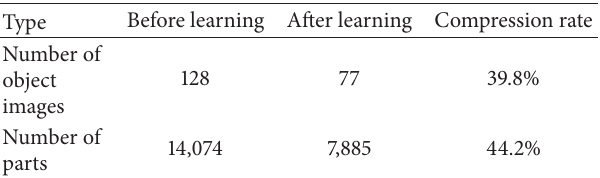
Table 2: Object learned